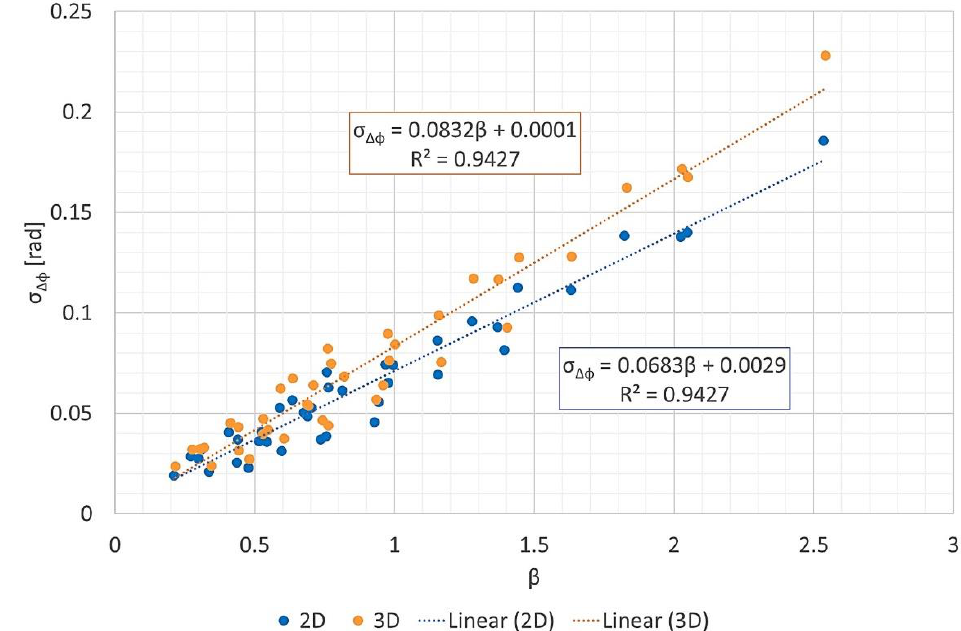
Figure 15. Phase error standard deviation 𝜎 ∆𝜙 vs. 𝛽 , with separate linear regressions for 2D and 3D data.